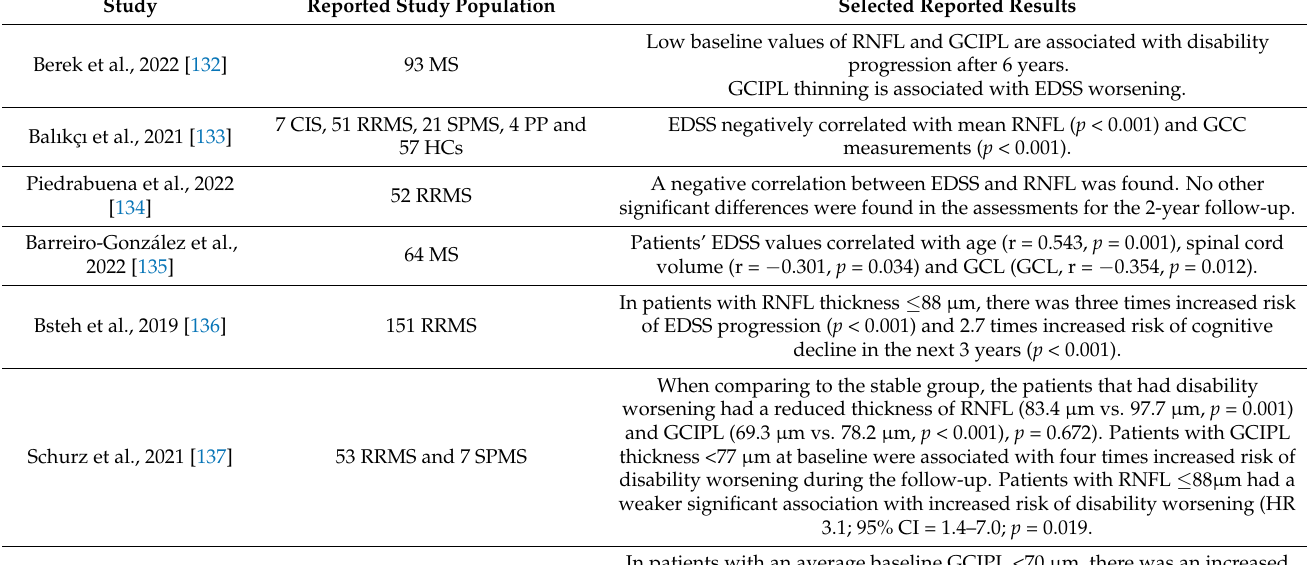
Table 3. Selected studies assessing correlations between OCT parameters and